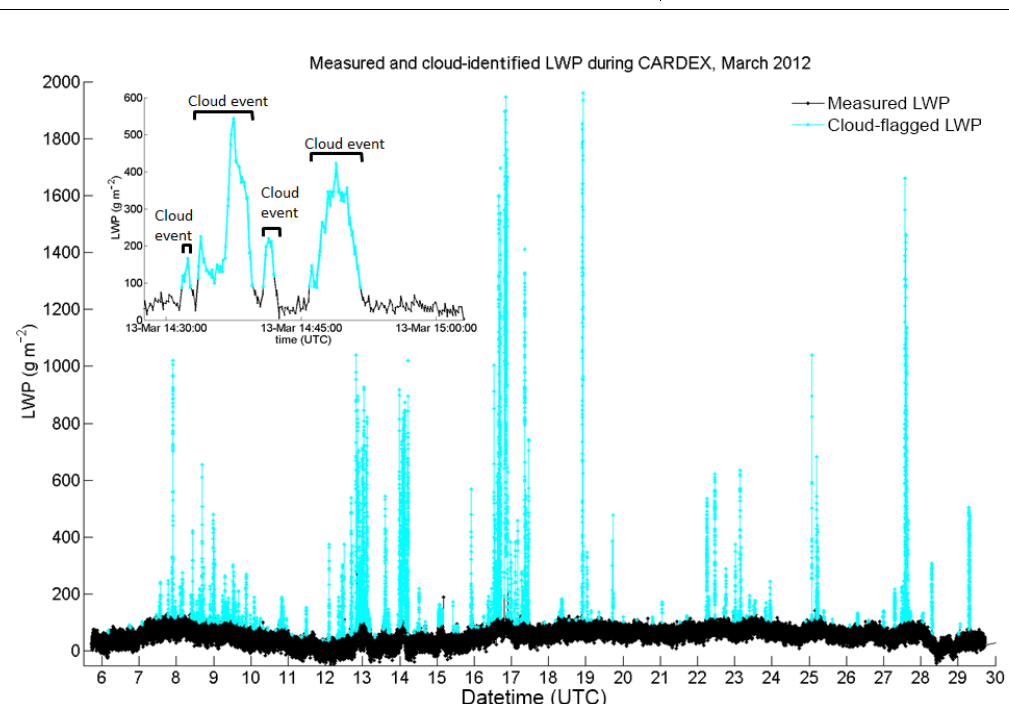
Figure 3. Liquid water path measured by the MWR operated during CARDEX. Cyan points indicate cloud-flagged values, and the inset illustrates an example of cloud events, as described in Appendix Sect.